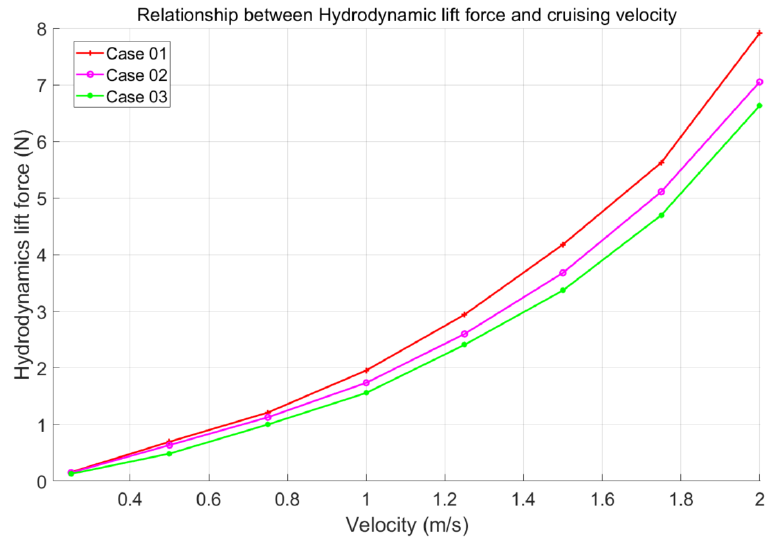
Figure 11. Variation of hydrodynamic lift with velocity.